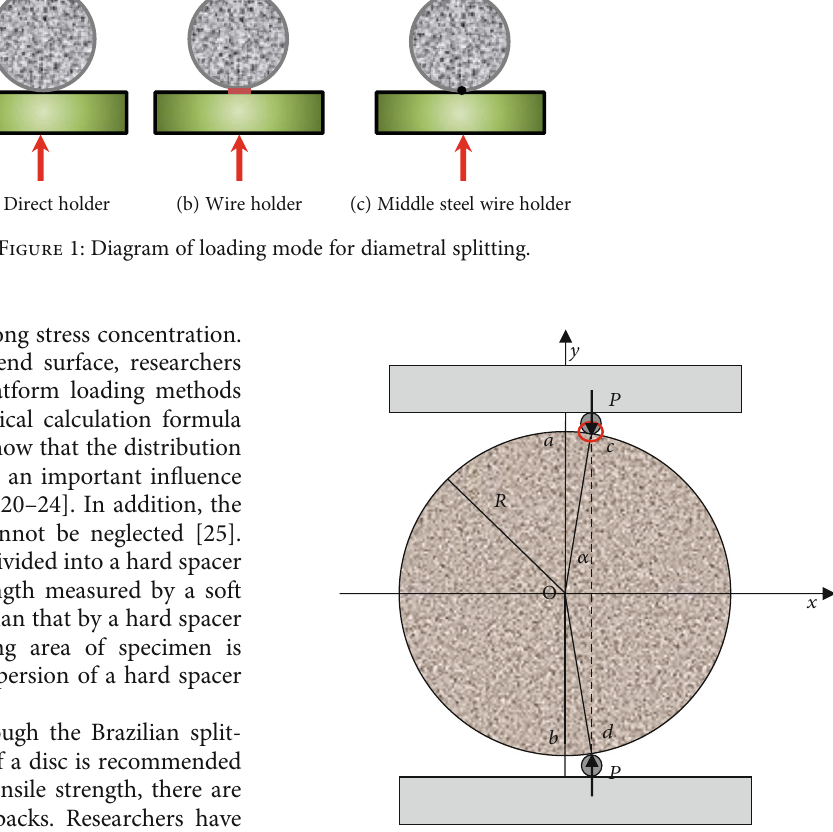
Figure 2: The compressed disc in the chord